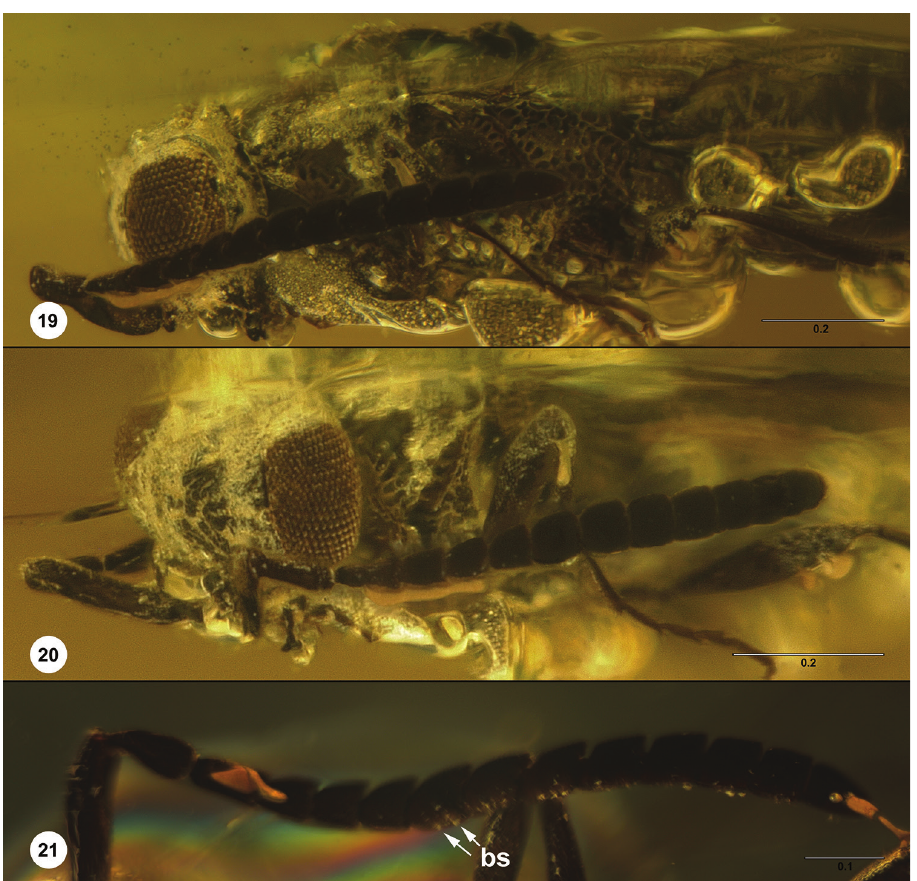
Figures 19–21. Proteroscelio nexus , female holotype (USNMENT01197245) 19 head and mesosoma, lateral view 20 head and mesosoma, anterolateral view 21 antenna, ventral view. Scale bars in Proteroscelio nexus Talamas, sp. n.